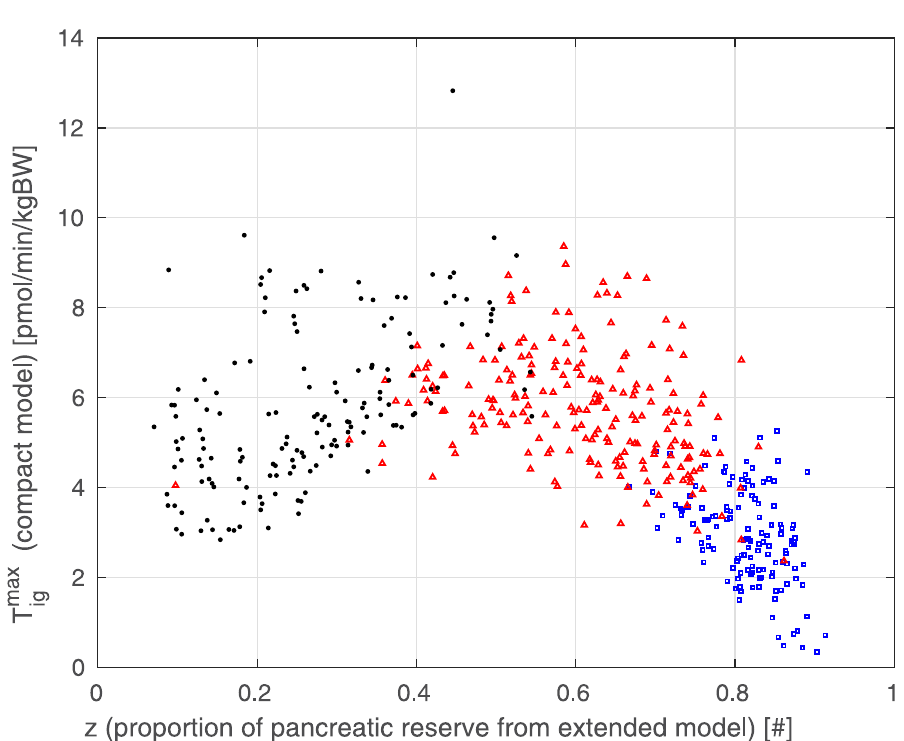
Fig 13. Dependence of Compact Model parameter T max (determined from estimated parameters) from proportion ig of pancreatic reserve z (extracted from generating Extended Model data) for NGR (blue squares), pre-diabetic (red triangles) and T2DM (black dots) patients.